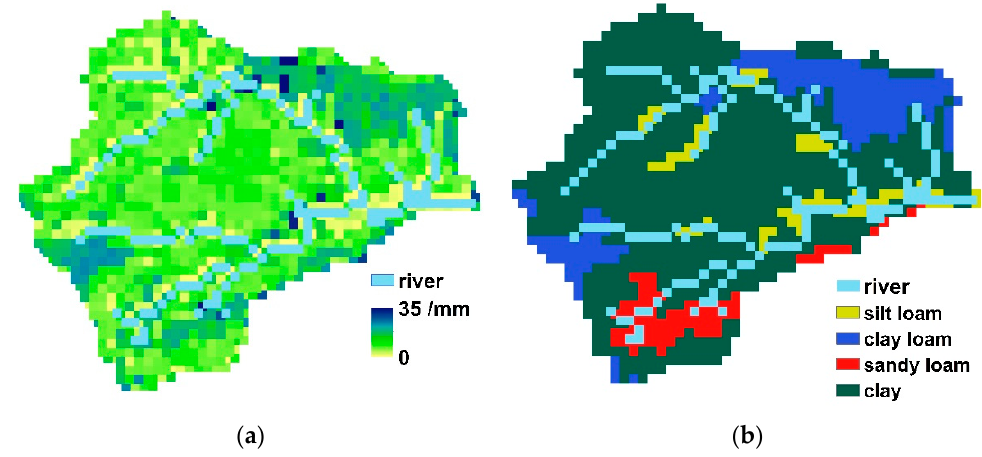
Figure 9. Spatial distribution of S M , estimated using the VS method and soil in the Changhua Watershed: ( a ) S M estimated using the VS method ( b ) Spatial distribution of soil.